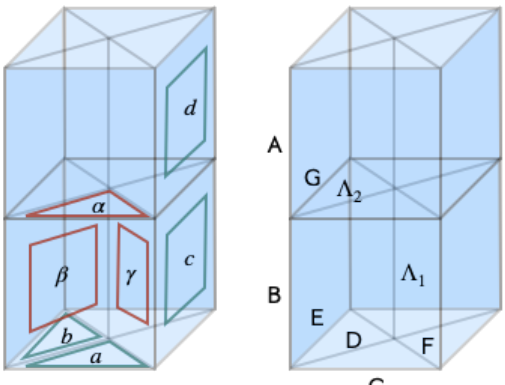
Figure 7: An illustration for a choice of cell complex for the point group ˜ R on an 4 z open geometry. The 2-cells are illustrated in panel (a) wherein the 2-cells a , b , c , d are each a representative of a certain ˜ R orbit on the surface of the depicted geom- 4 z etry. Likewise α , β and γ each label a certain ˜ R orbit in the bulk of the geometry. 4 z Similarly, panel (b) illustrates the distinct ˜ R orbits for the 1-cells. The representa- 4 z tives of the surface orbits are denoted A , B ,..., G while the bulk orbit representatives are denoted as Λ and Λ 1 2